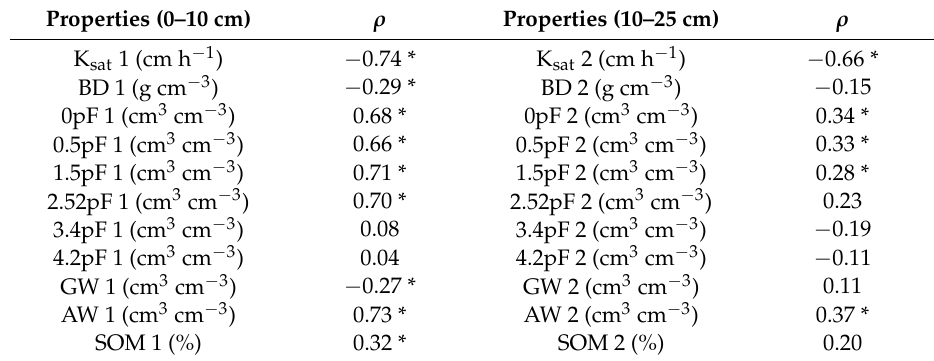
Table 4. Spearman correlation coefficients ( ρ ) between elevation and the hydro-physical properties and SOM content of the soil layer at 0–10 cm and 10–25 cm in the undisturbed natural cover